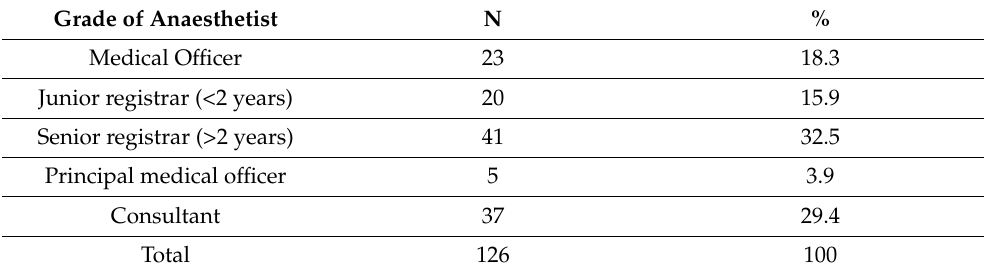
Table 2. Responses according to grade of anaesthetist.